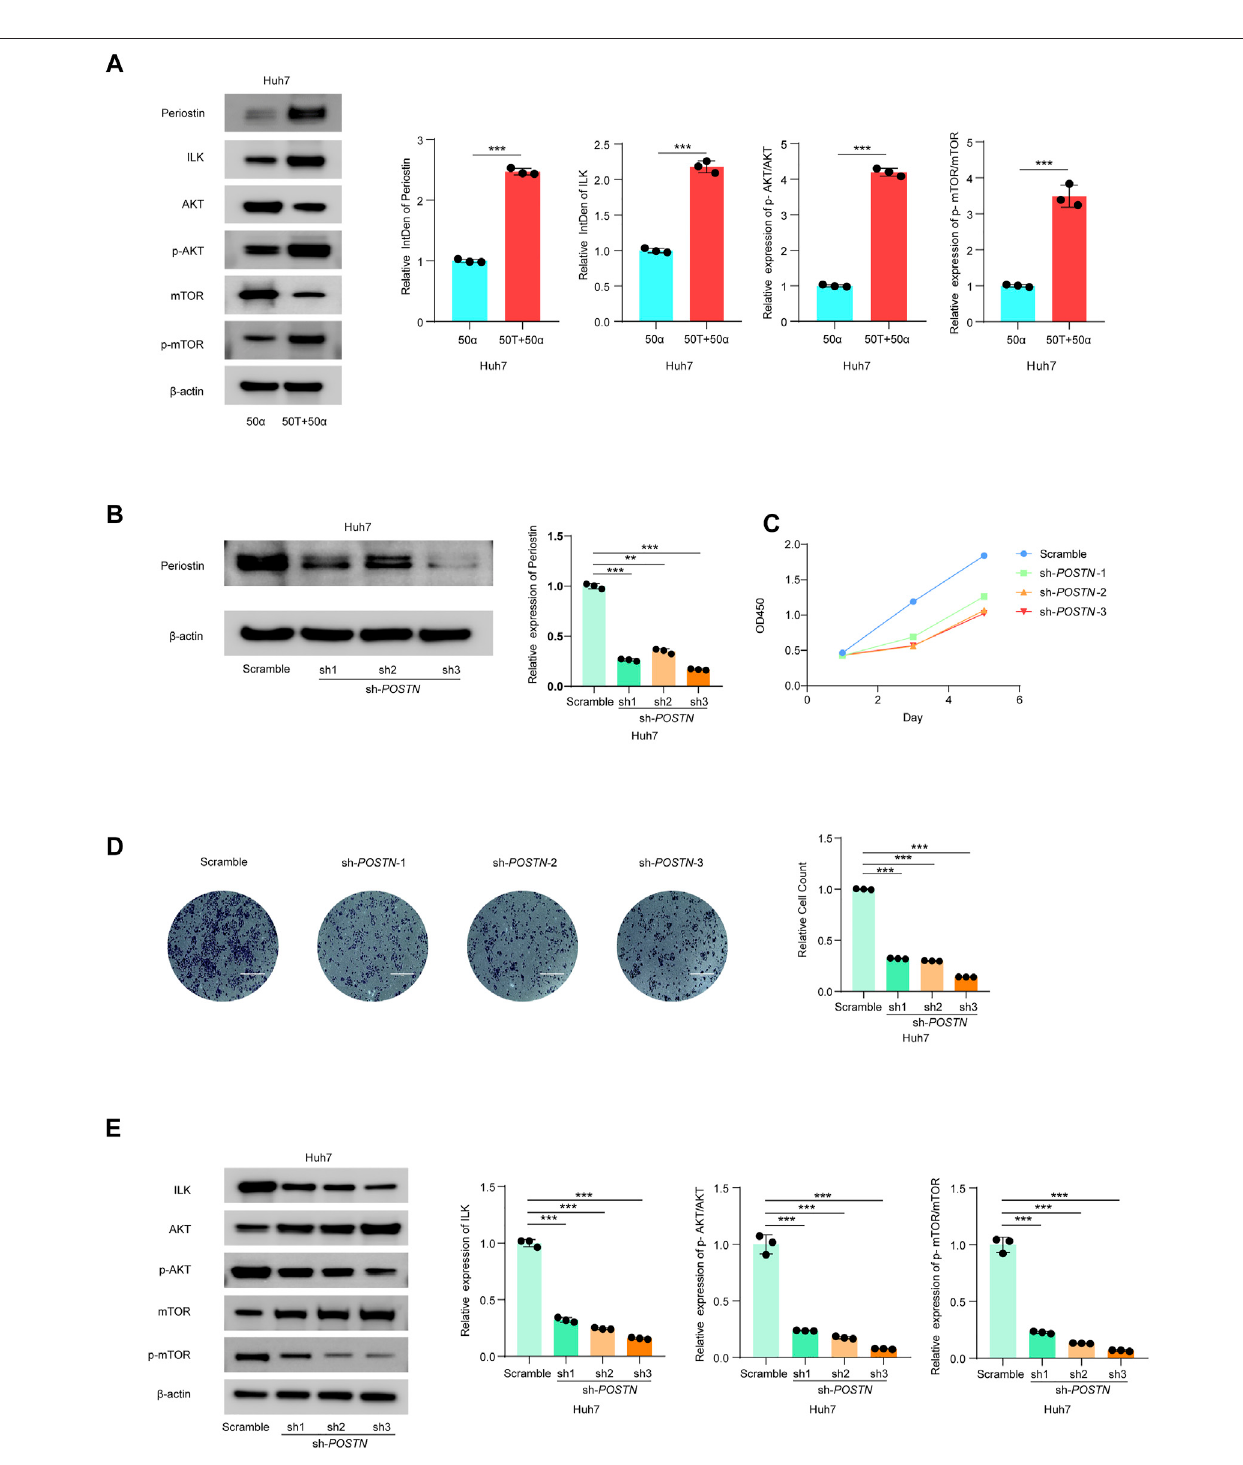
FIGURE 8 | TMAO activates ILK/AKT/mTOR signaling via Postn in Huh7 cells. (A) The translation levels of POSTN, ILK, AKT, p-AKT, mTOR and p-mTOR measured by western blotting in Huh7 cells treated with 50 ng/ml TNF- α combined with 50 μ M TMAO or 50 ng/ml TNF- α alone. Grayscale values were analyzed; data are mean ± SD ( n = 3 per group); Student ’ s t-test; ***, p < 0.001. (B) POSTN translation levels in Huh7 cells infected with pseudovirus expressing sh- POSTN (sh1, sh2, sh3) plasmids were compared with the Huh7 cells infected with pseudovirus expressing scramble plasmids measured by western blotting. Grayscale values were analyzed; data are mean ± SD ( n = 3 per group); one-way ANOVA with Bonferroni ’ s test; ***, p < 0.001. (C ) CCK-8 assay of the effect of knocking down POSTN on the proliferation of Huh7 cells; data are mean ± SD ( n = 3 per group); one-way ANOVA with Bonferroni ’ s test; ***, p < 0.001. (D) Transwell assays of the effect of knocking down POSTN on the invasive abilities of Huh7 cells. Scalebars = 100 μ m; Data were analyzed by ImageJ; data are mean ± SD ( n = 3 per group); one-way ANOVA with Bonferroni ’ s test; ***, p < 0.001. (E) Westernblots of theeffectsofknocking down POSTN on the protein levels ofPostn, ILK, AKT, p-AKT, mTOR and p-mTOR in Huh7 cells. Grayscale values were analyzed; data are mean ± SD ( n = 3 per group); one-way ANOVA with Bonferroni ’ s test; ***, p < 0.001.